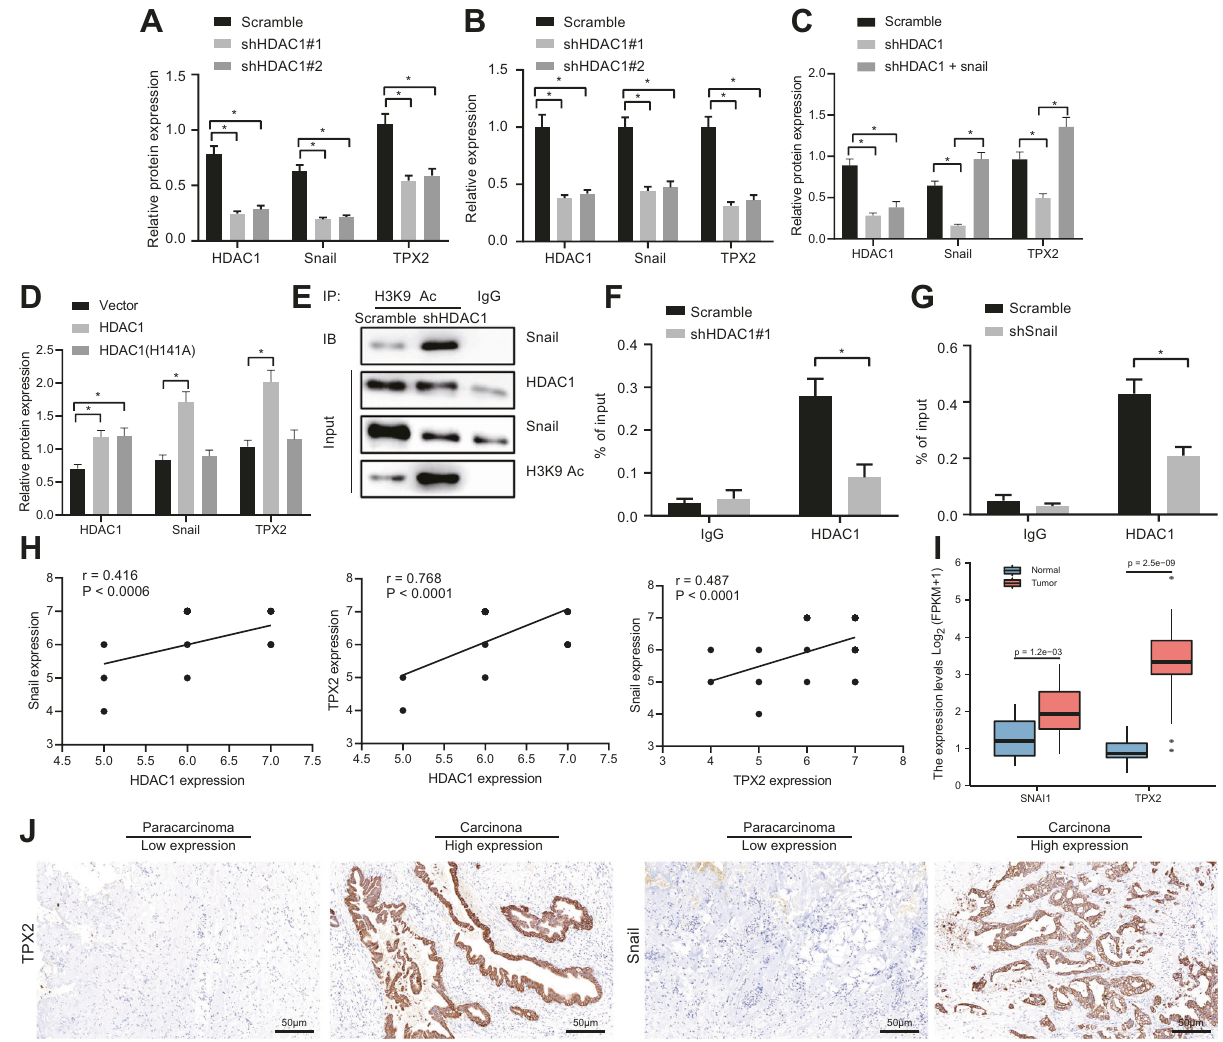
Fig. 6 HDAC1 silencing downregulated the TPX2 expression via suppression of Snail. A The protein expression of Snail in TFK-1 cells upon HDAC1 silencing measured by Western blot analysis. B mRNA expression of Snail in TFK-1 cells upon HDAC1 silencing measured by RT-qPCR. C TPX2 protein expression in TFK-1 cells after HDAC1 silencing alone or with Snail overexpression in combination measured by Western blot analysis. D The expression of Snail and TPX2 proteins following HDAC1 mutation measured by Western blot analysis. E The interaction between Snail and H3K9 histone acetylation upon HDAC1 silencing identi fi ed by IP assay. F The enrichment of HDAC1 and Snail on the TPX2 promoter upon HDAC1 silencing assessed by ChIP. G The enrichment of HDAC1 and Snail on the TPX2 promoter upon Snail silencing assessed by ChIP. H Correlations of HDAC1 with TPX2 and Snail in clinical CC tissues ( n = 65) analyzed using immunohistochemistry. I TCGA database analysis of Snail and TPX2 proteins in CC tissues ( n = 36) and normal tissues ( n = 9). J Immunohistochemical staining of Snail and TPX2 proteins in CC tissues ( n = 65) and normal tissues ( n = 35). * p < 0.05. In panels ( A – E ), data were compared by one-way ANOVA with Tukey ’ s post hoc test. In panels ( F ) and ( G ), data were compared using unpaired t -test. The cell experiment was independently repeated three